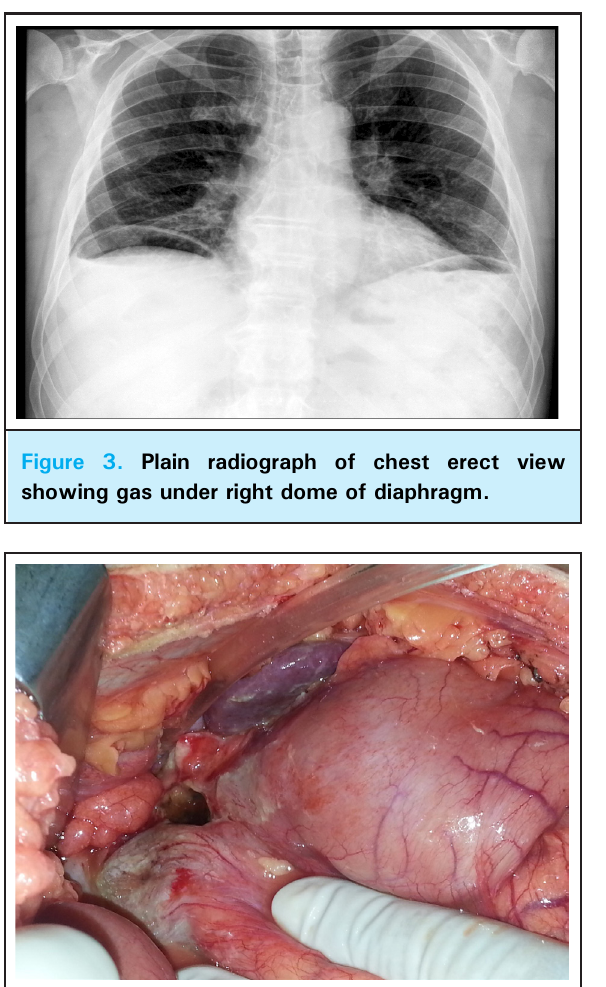
Figure 4. Intra-operative findings of perforation on the pylorus of the